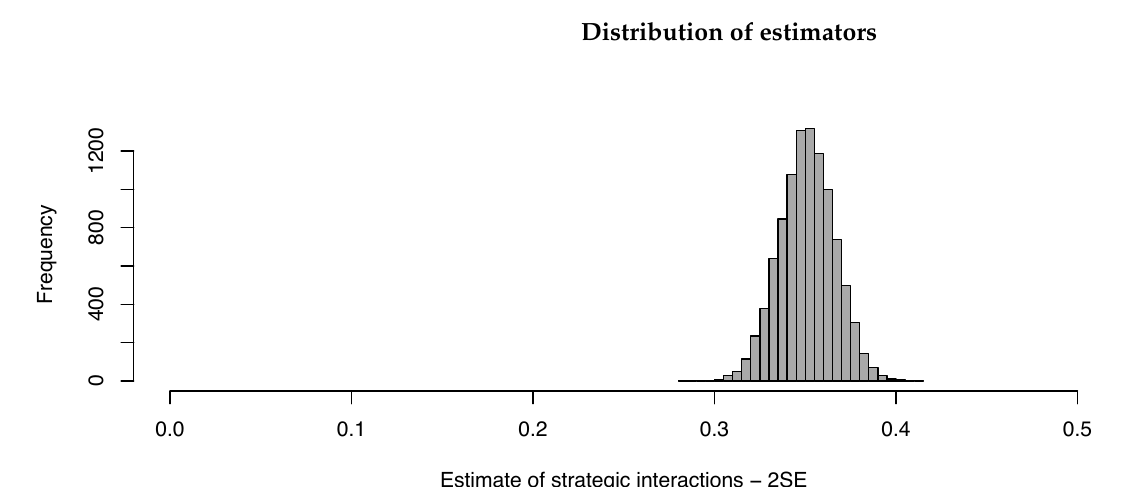
Figure 4. Distribution of estimated β N minus 2SE for randomly sampled network structures. Inter- pretation of β N : + 1 w t N corresponds to +( 100% × β N ) increase in w t i